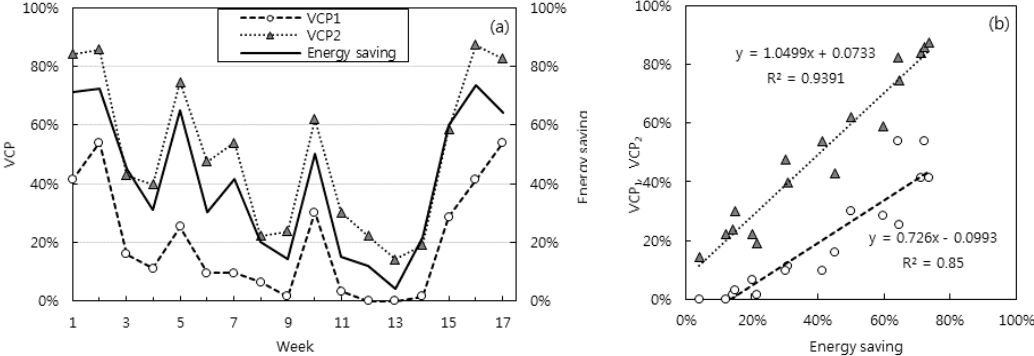
Figure 7. Summary of VCPs and energy savings in Seoul: ( a ) weekly VCPs and energy savings and ( b ) correlation between VCPs and energy savings.